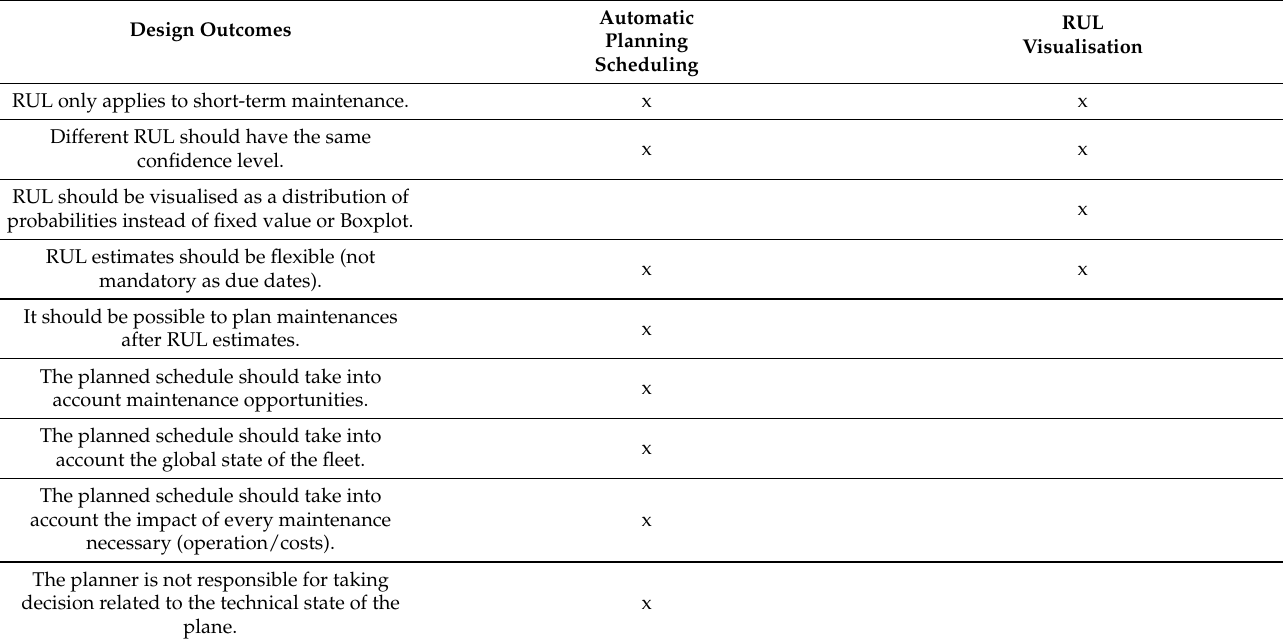
Table 1. List of main design outcomes that can be incorporated into the design of the Automatic Planning Agent and RUL visualisation. The letter “x” address the design outcomes to the ML